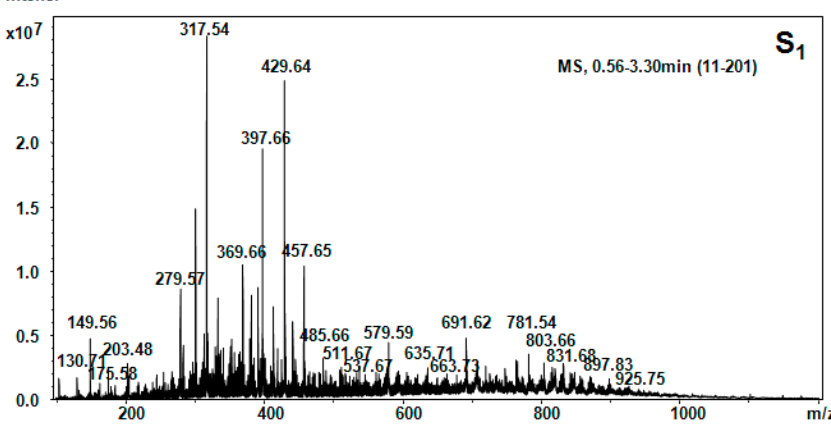
Figure 3. Positive ion mode nano-ESI-Chip-MS forS 1 hellebore fraction.